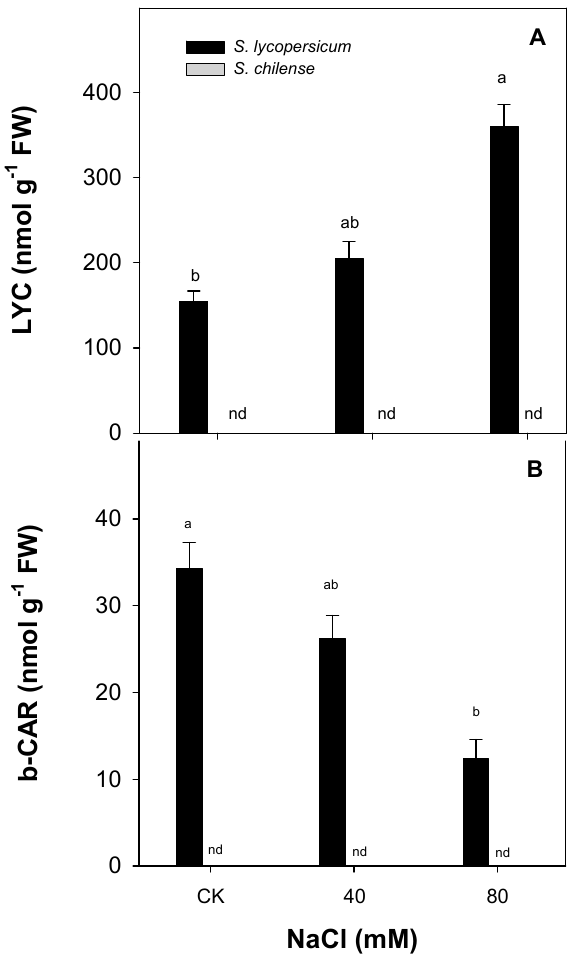
Figure 3. Fruit lycopene (LYC) (nmol g − 1 FW; ( A )) and β -carotene (b-CAR) content (nmol g − 1 FW; ( B )) in two species of tomato (domesticated Solanum lycopersicum and wild-relative S. chilense ) cultivated for 112 days in nutrient solution containing 0 (control treatment, CK), 40 or 80 mM NaCl. Each value represents the mean ± SE ( n = 6). Lower-case letters indicate differences ( p ≤ 0.05, Duncan test) between treatments and species.